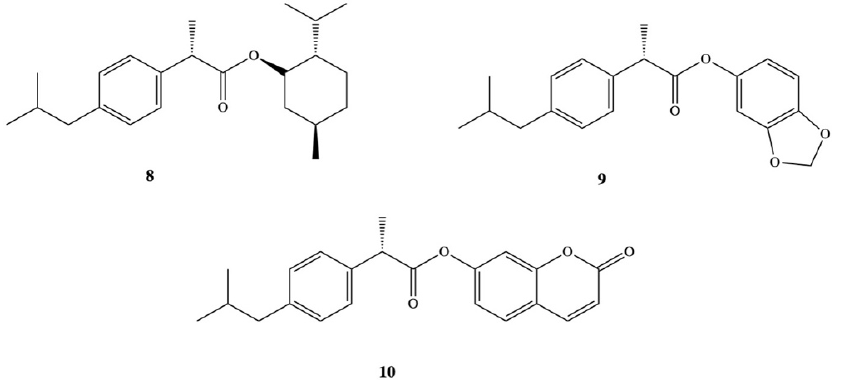
Figure 6. Dexibuprofen-antioxidant mutual prodrugs.